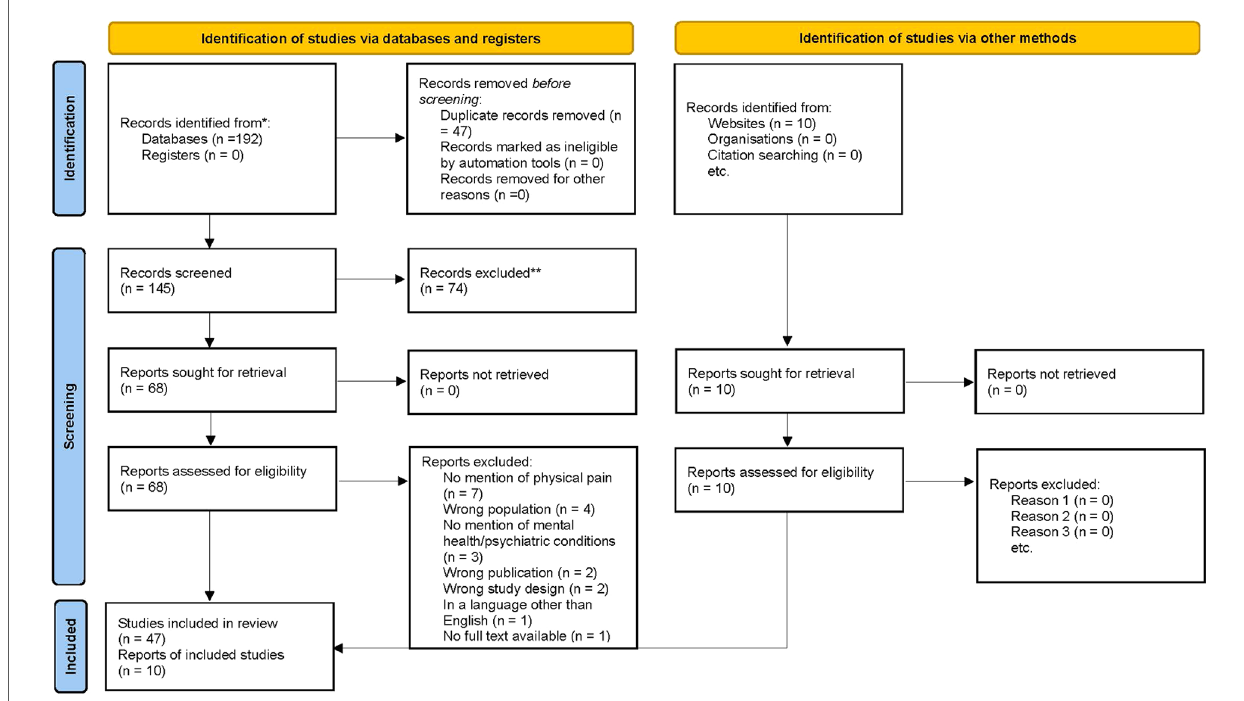
FIGURE 1 PRISMA 2020 fl ow diagram for new systematic reviews which included searches of databases, registers and other sources. Citation: From: Page MJ, McKenzie JE, Bossuyt PM, Boutron I, Hoffmann TC, Mulrow CD, et al. The PRISMA 2020 statement: an updated guideline for reporting systematic reviews. BMJ 2021;372:n71. doi: